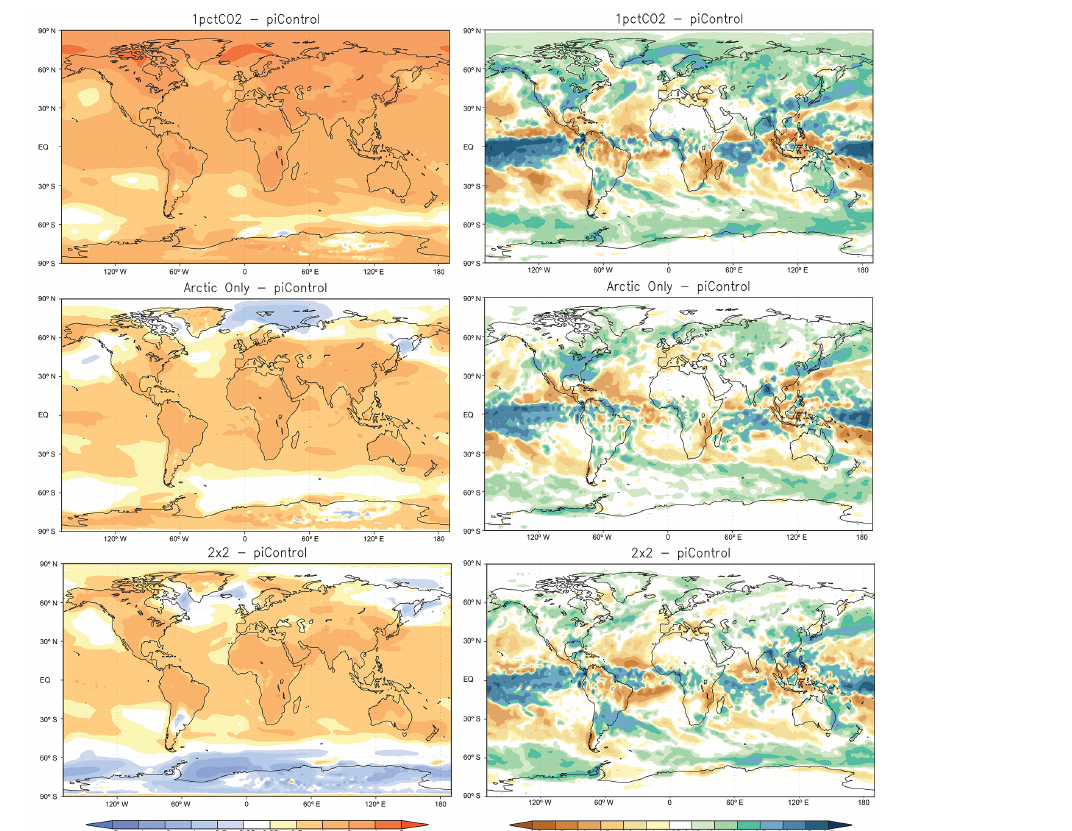
Figure 16. Same as Fig. 13 but for GISS ModelE2 (the evaluation